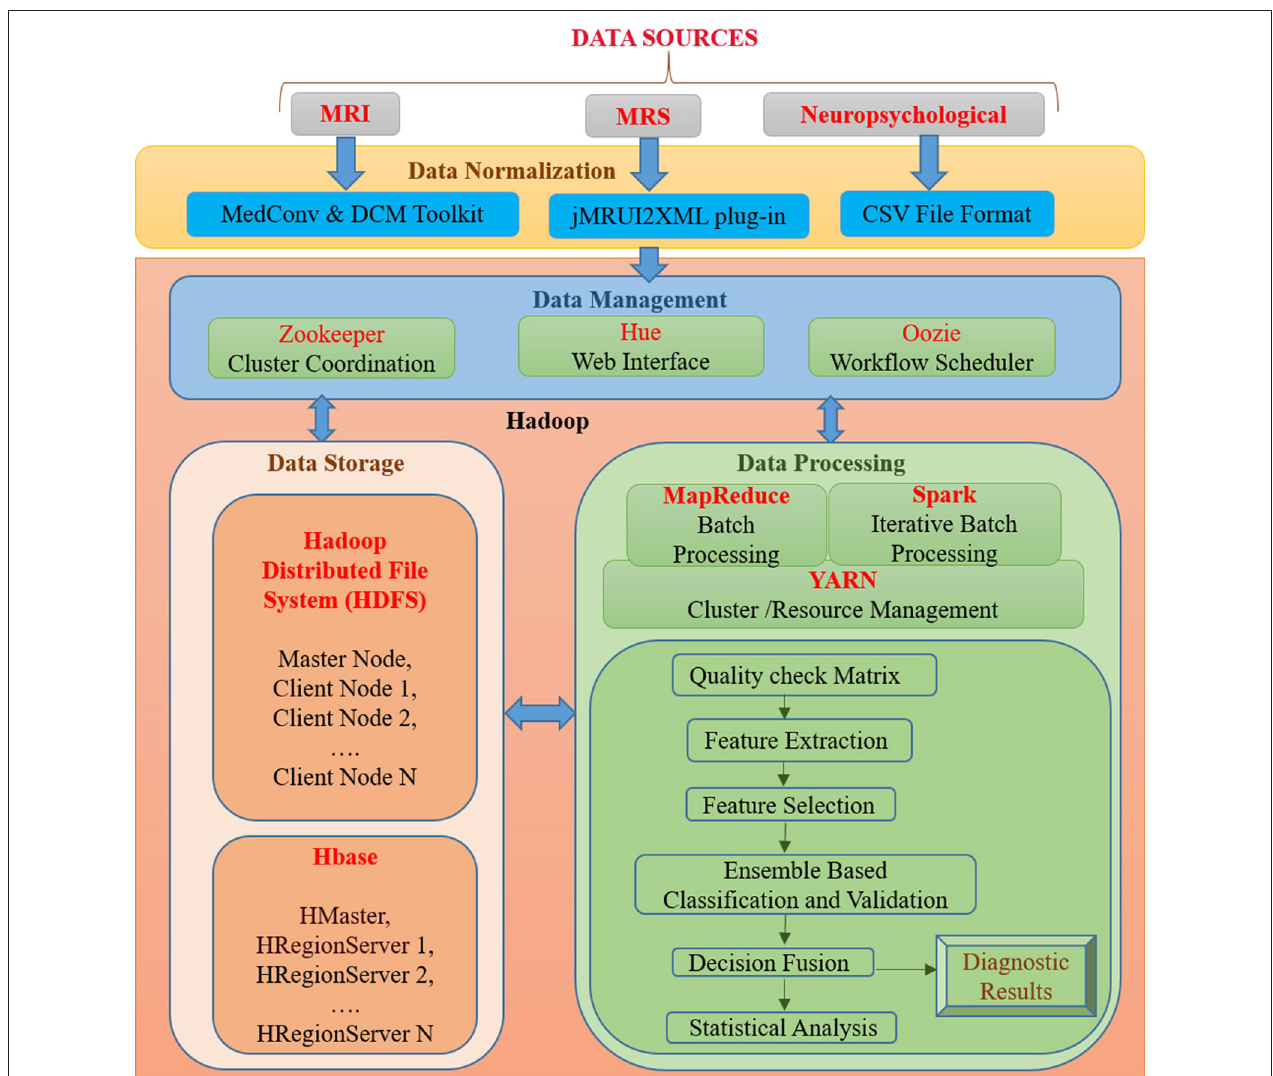
FIGURE 1 | An integrated framework for Big Data Analytics (BHARAT) using Hadoop with four components: Data Normalization, Data Management, Data Storage, and Data Processing. Data Normalization includes conversion of raw data into a suitable format for further processing, which is collected from diverse data sources. Data Management deals with organization and management of data from diverse sources. For example, Zookeeper helps in maintaining synchronization among distributed sources and Hue supports querying and visualization of data. Data storage consists of the HDFS file storage system to store a large amount of data and HBase is a NoSQL database used to read/write data in real time. Data Processing component contains different packages and libraries for processing and analysis of data from different modalities. It performs feature extraction, selection, classification, and decision fusion for accurate classification of data followed by